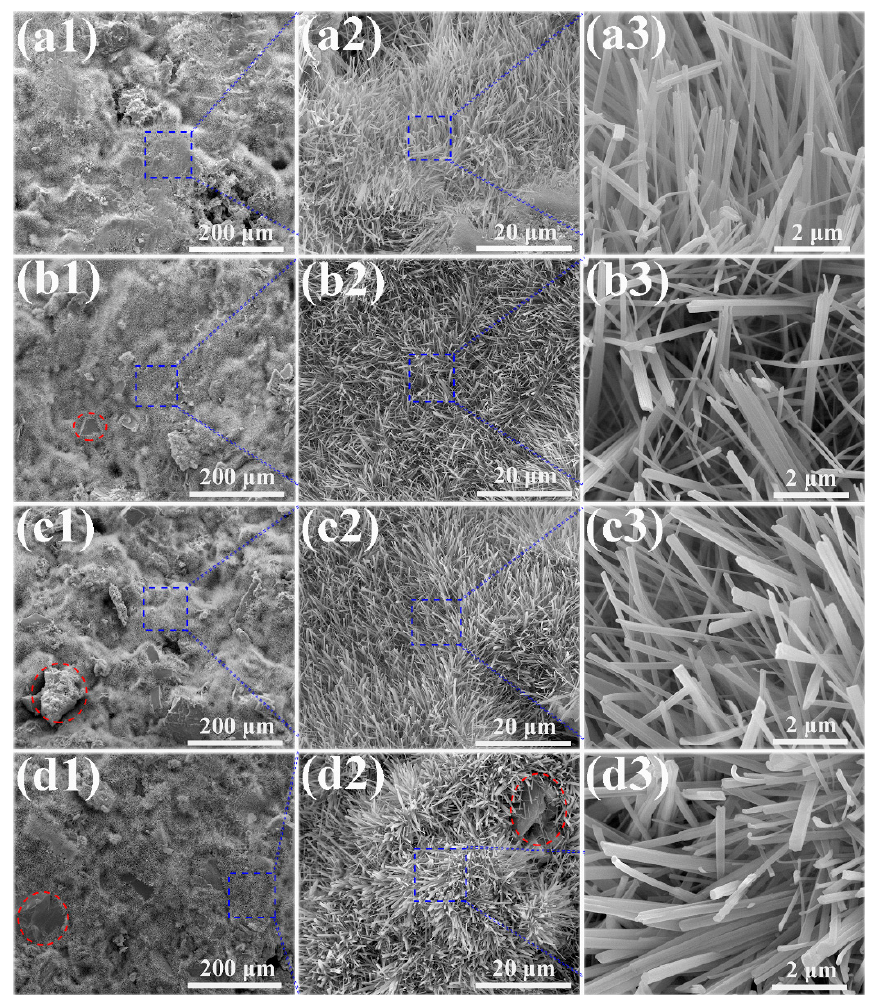
Figure 3. SEM morphologies of the fractured surfaces of different samples. ( a1 ), ( a2 ) and ( a3 ) pure MOC; ( b1 ), ( b2 ) and ( b3 ) MOC-10FD; ( c1 ), ( c2 ) and ( c3 ) MOC-20FD; ( d1 ), ( d2 ) and ( d3 ) MOC-30FD.